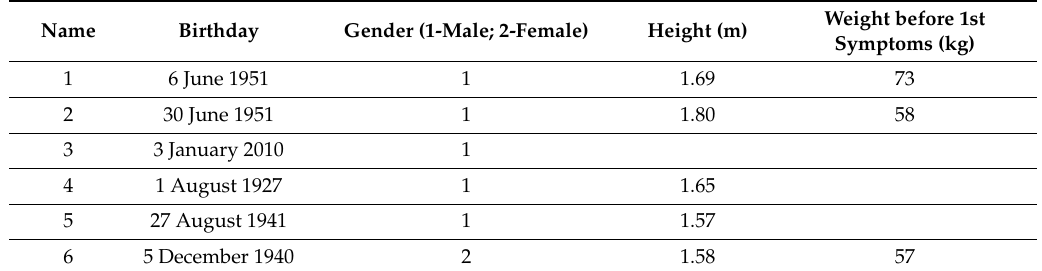
Table 6. Demographics input table using a comma-separated values